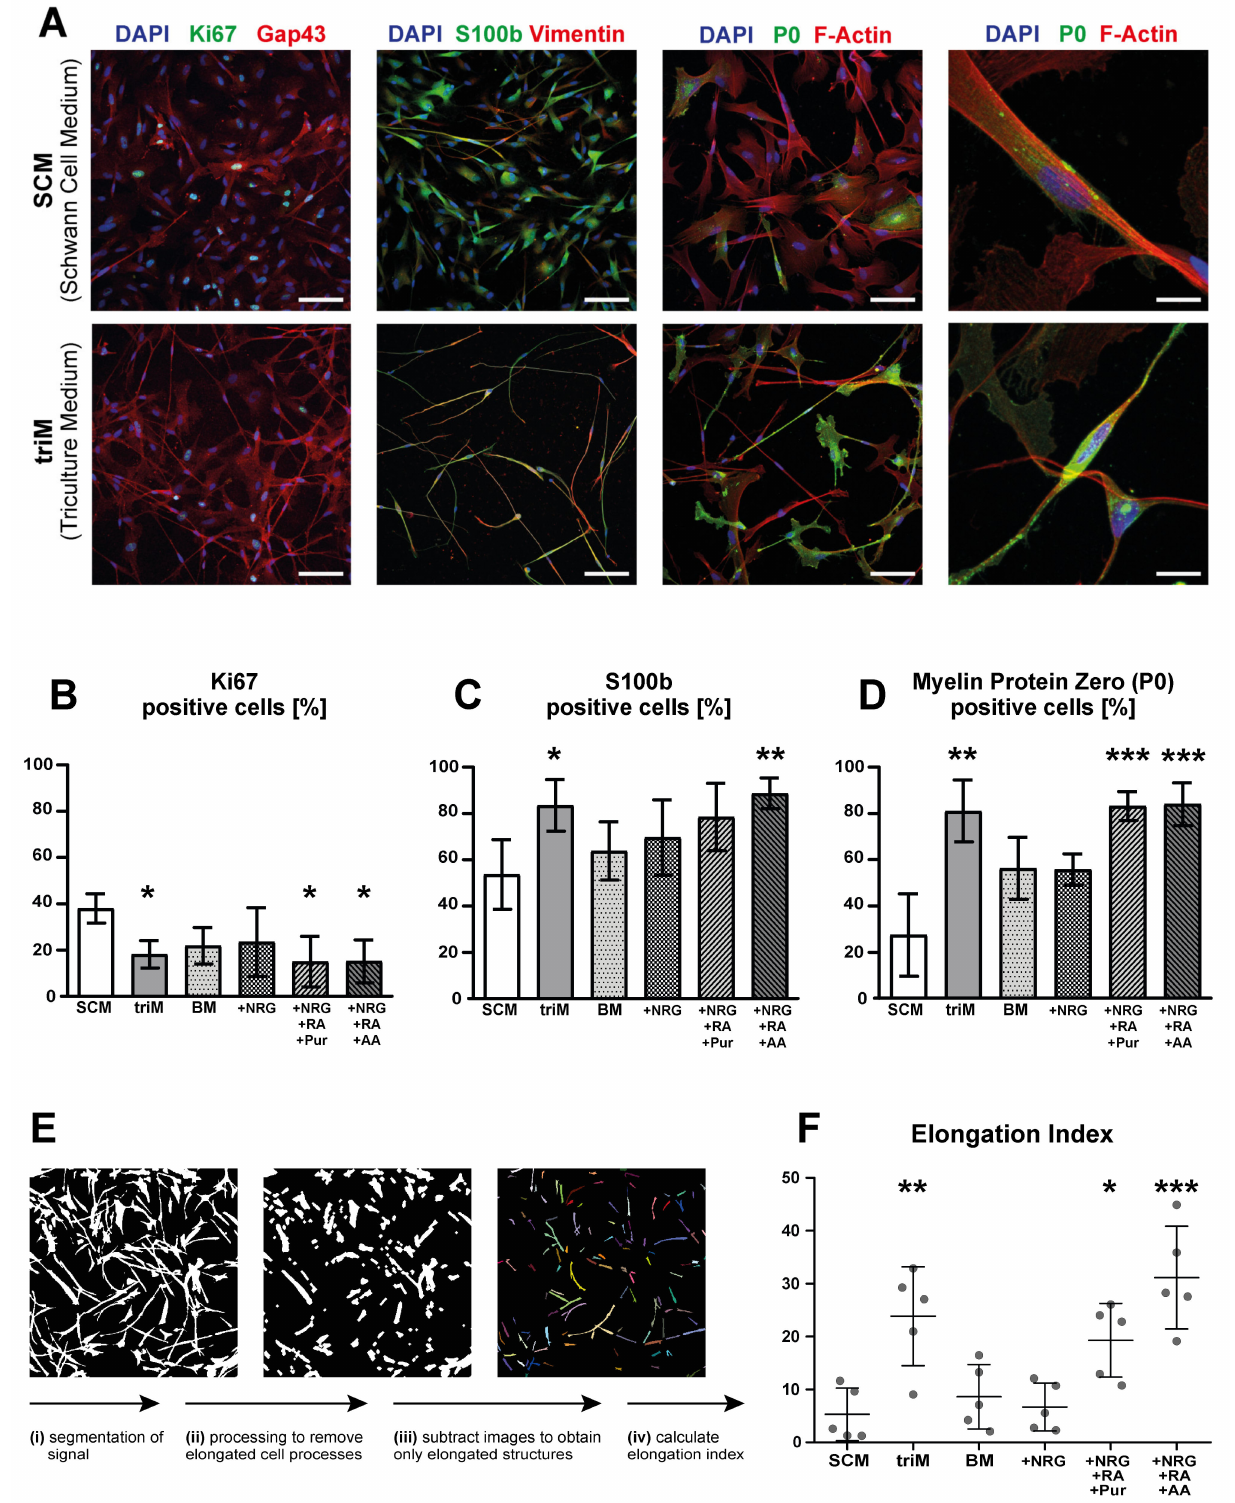
Figure 4. Triculture medium promotes differentiation of hiPSC-derived Schwann cells. SC differentiated from hiPSC using the SC differentiation protocol, including BMP4 tuning, were cultured for three days in either standard SC medium